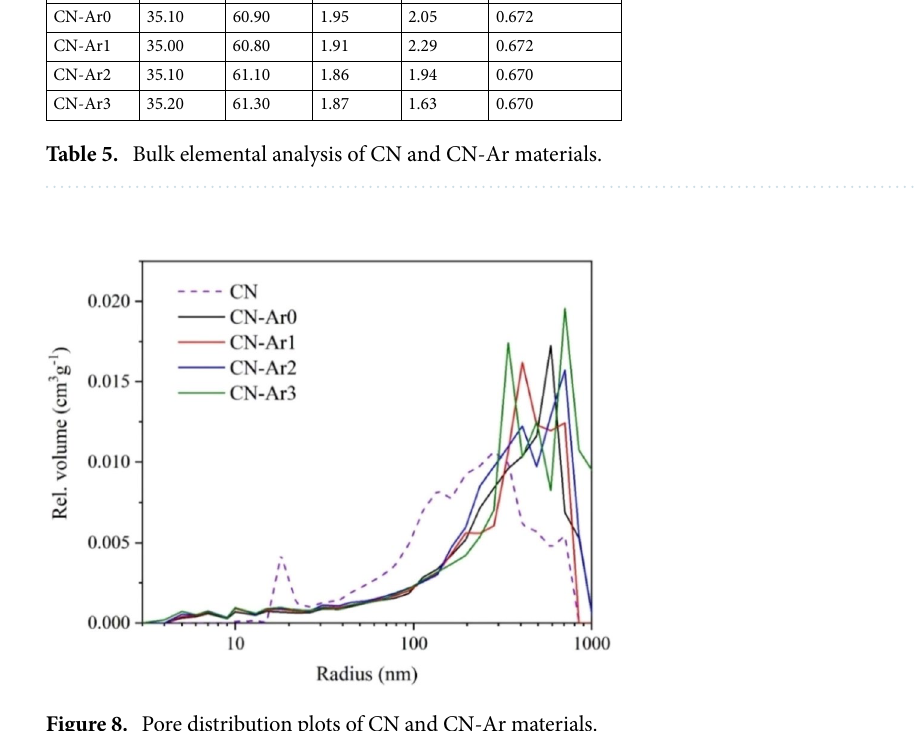
Figure 8. Pore distribution plots of CN and CN-Ar